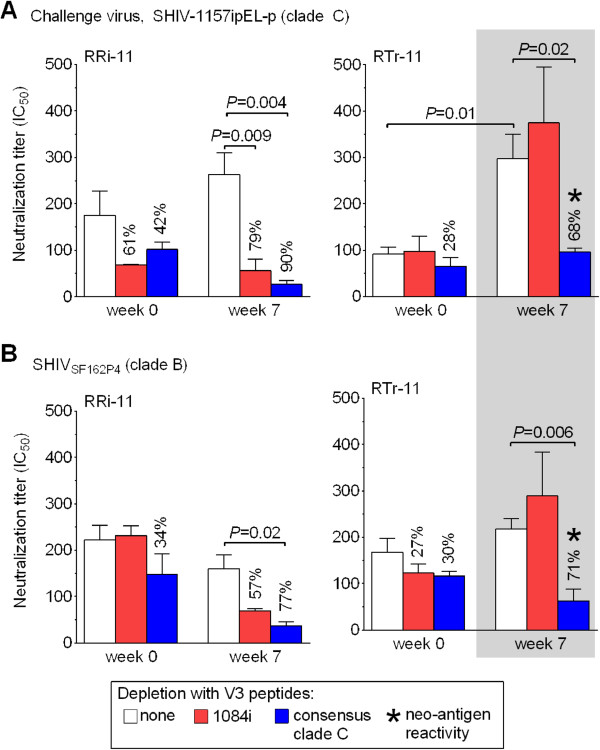
Induction and boosting of cross-neutralizing anti-V3 Abs in the absence of viremia. Plasma samples (weeks 0 and 7) were tested for neutralizing activity against the challenge virus, SHIV-1157ipEL-p (A) and the heterologous clade B SHIVSF162P4 (B) by TZM-bl assay [20]. Neutralization titers are expressed as the reciprocal plasma dilution inhibiting 50% of virus infection (IC50). Each bar represents the average titer of at least two independent assays using triplicates of each sample and error bars show the SEM. Plasma nAb titers were compared between weeks 0 (before live-virus challenges) and 7 (after 5x multiple low-dose challenges). Plasma samples were incubated with either medium (plasma only, white bars) or one of the two peptide sets (red bars, 1084i V3; blue bars, consensus clade C V3) and IC50 values were calculated. In case of a decreased IC50 (depletion of neutralizing activity), percentages illustrate the degree of inhibition reached with each peptide set. P-values are shown (significance after Bonferroni correction, P < 0.025). Gray box and asterisks indicate neoantigen reactivity.